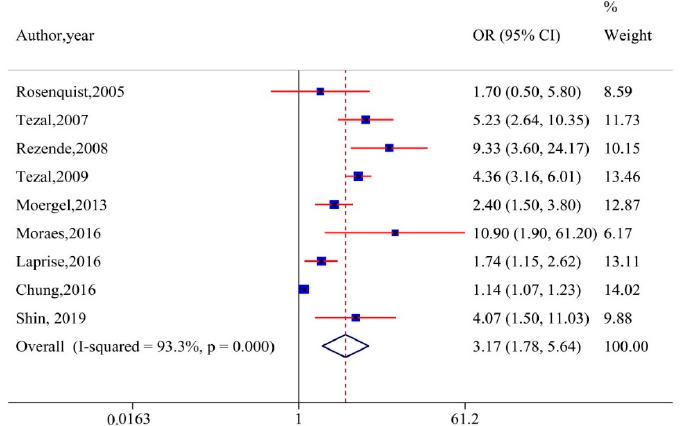
Figure 2. Forest plot of periodontal disease and risk of head and neck cancer (random-effects model). CI, confidence